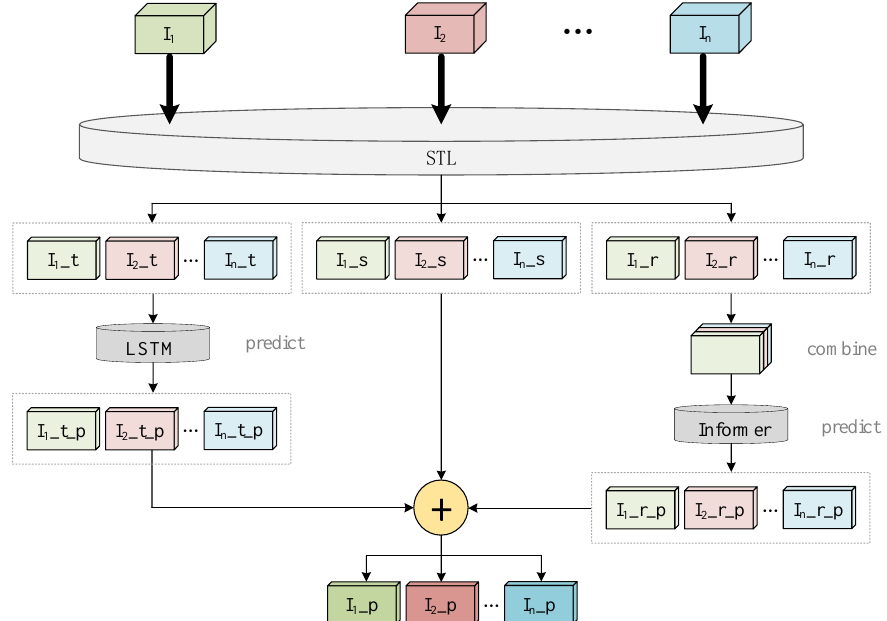
Figure 3. The fundamental structure of the decomposition-based multi-step forecasting model for the environmental variables of rabbit house.